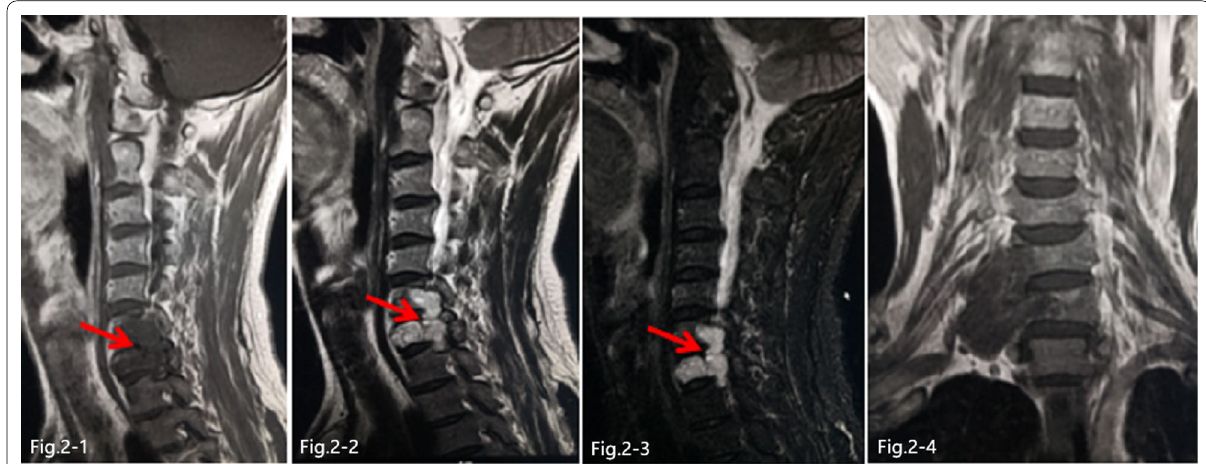
Fig. 2 (2-1) Sagittal image on T1WI, (2-2) Sagittal image on T2WI, (2-3) Sagittal image on STIR, (2-4) Coronal contrast-enhanced image on T1WI. Tumor margin appears lobulated. Slightly hypointense on T1WI, slightly hyperintense on T2WI and STIR are seen in (2-1, 2-2, 2-3). Multiple patchy